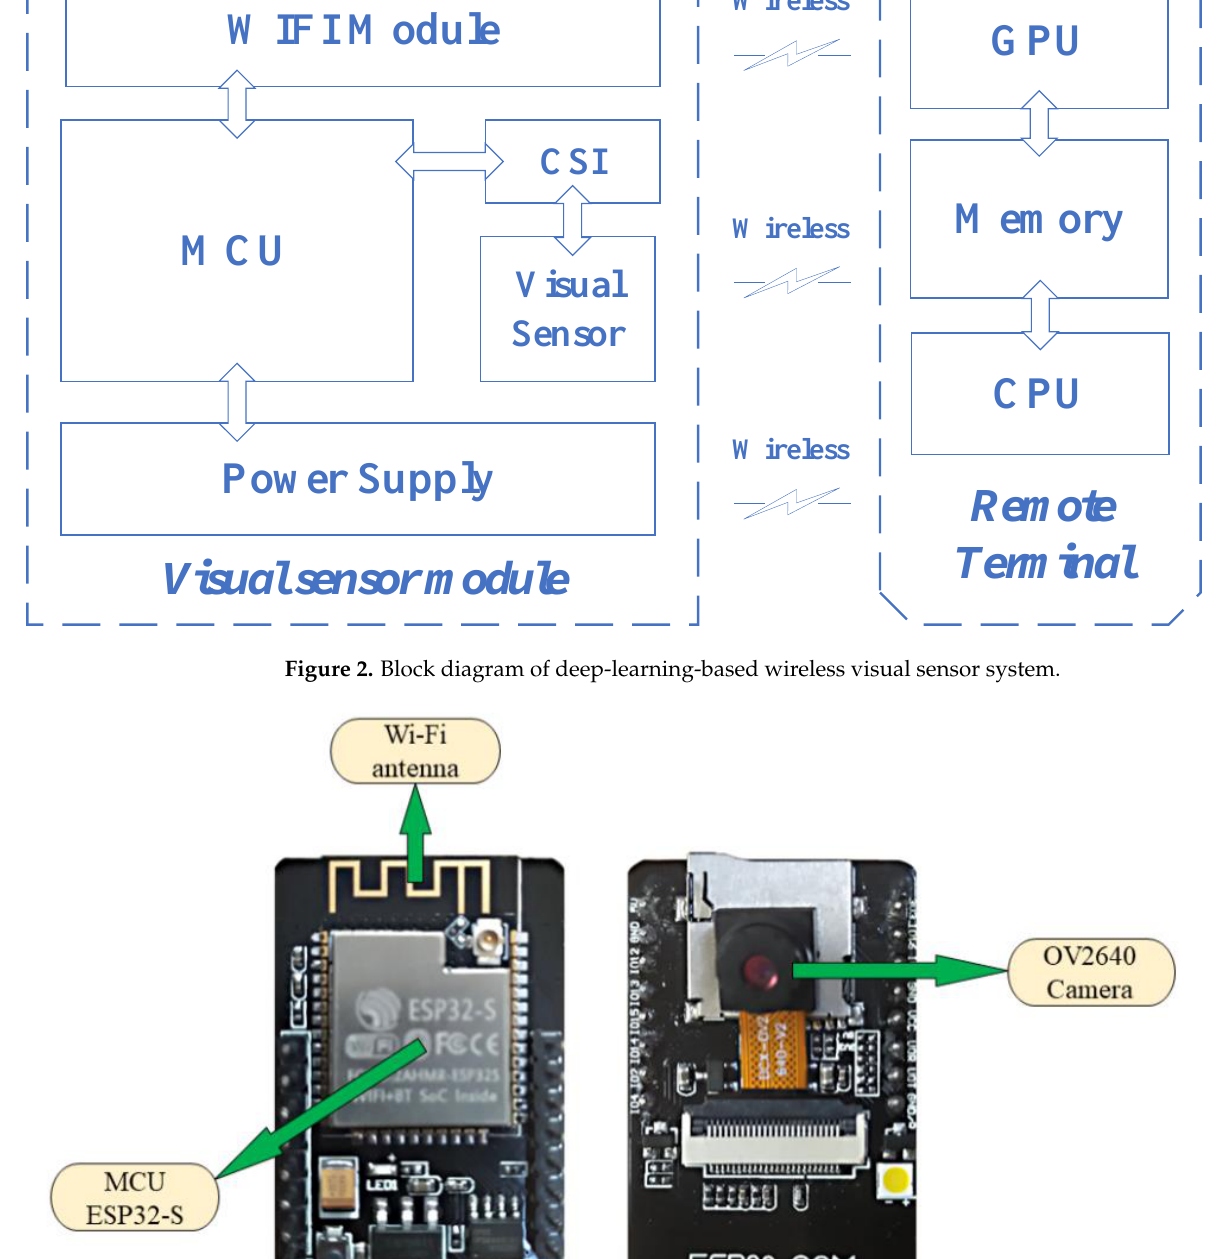
Figure 3. Physical implementation of deep-learning-based wireless visual sensor system.